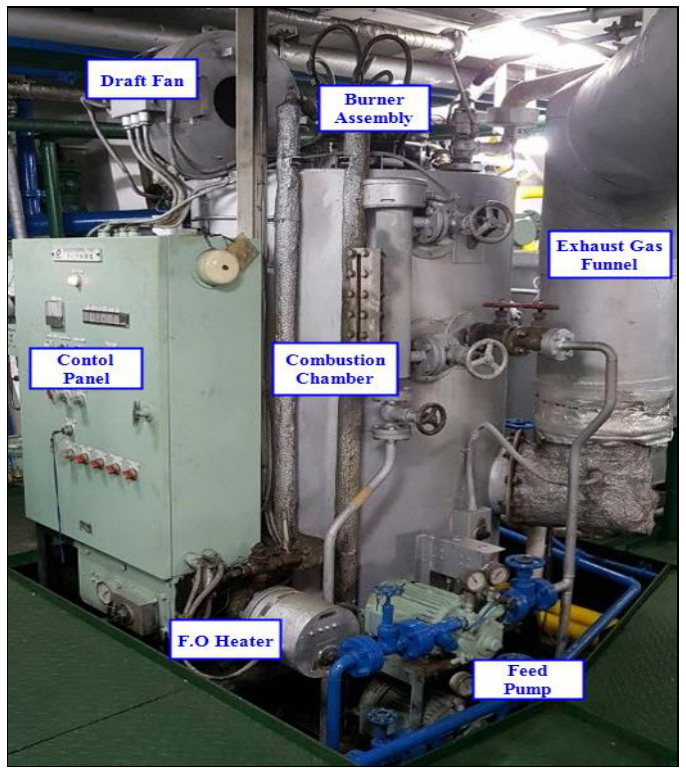
Figure 5. Photograph of marine boiler assembly. Table 2. Marine boiler specifications.